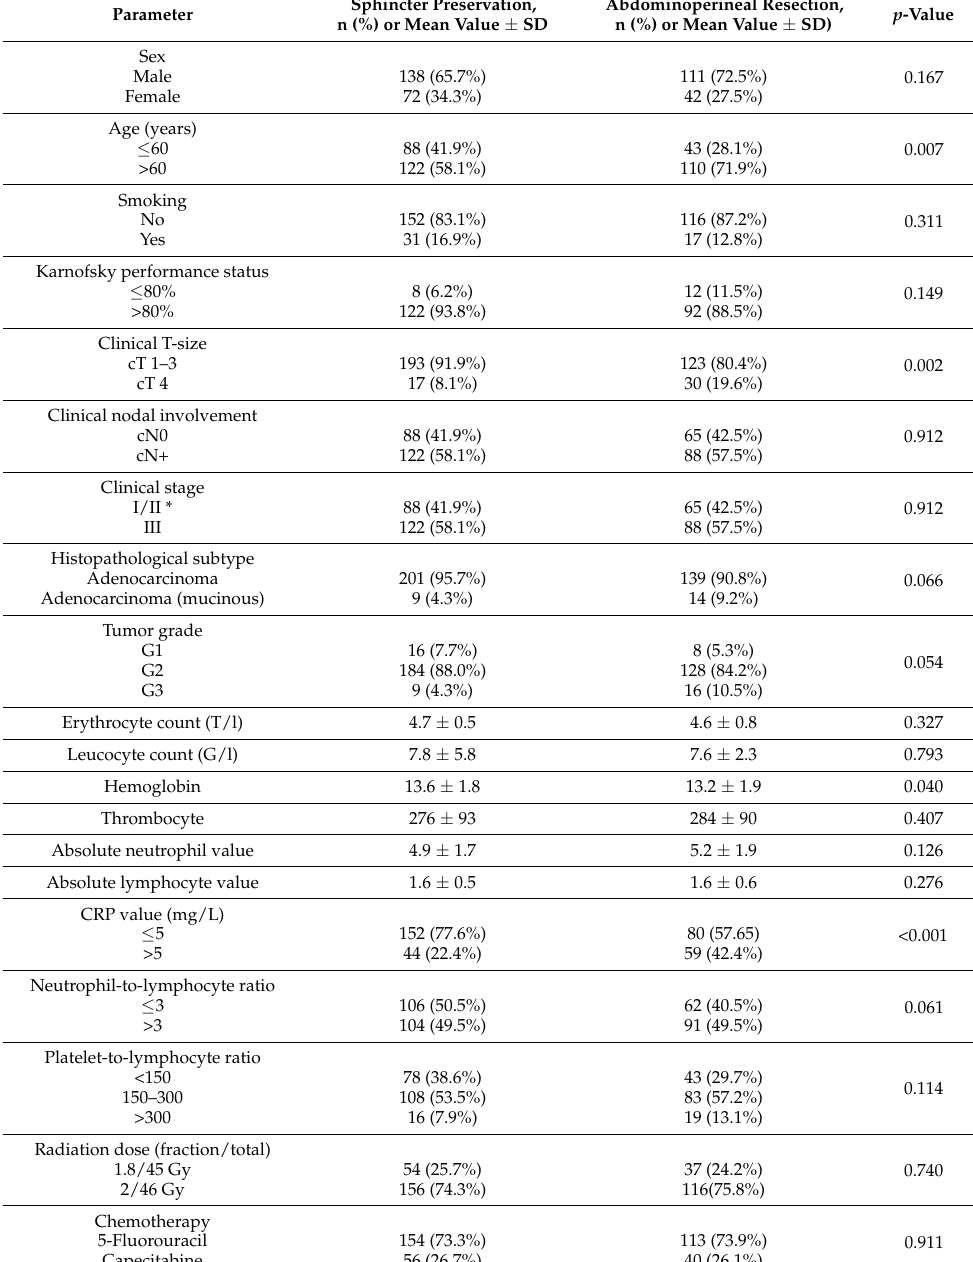
Table 2. Patient and tumor parameters: results of univariable